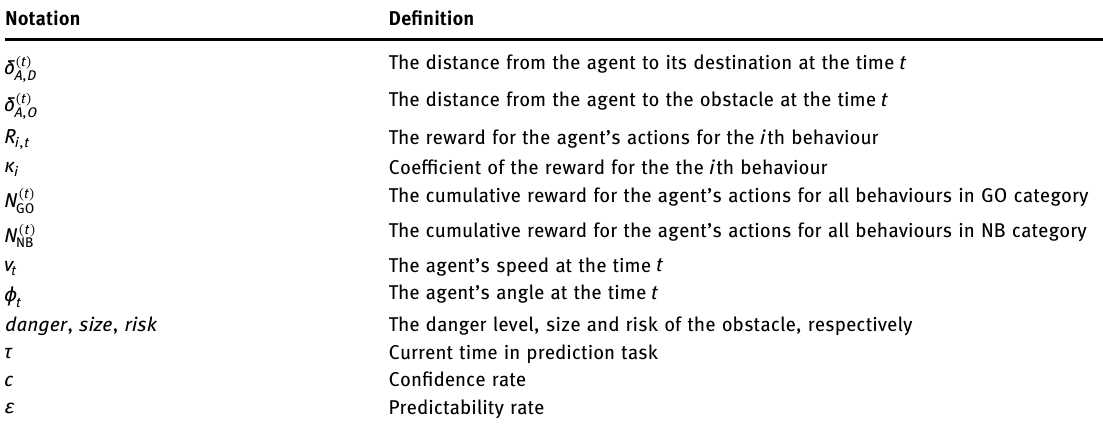
Table 2: Notations used in the article